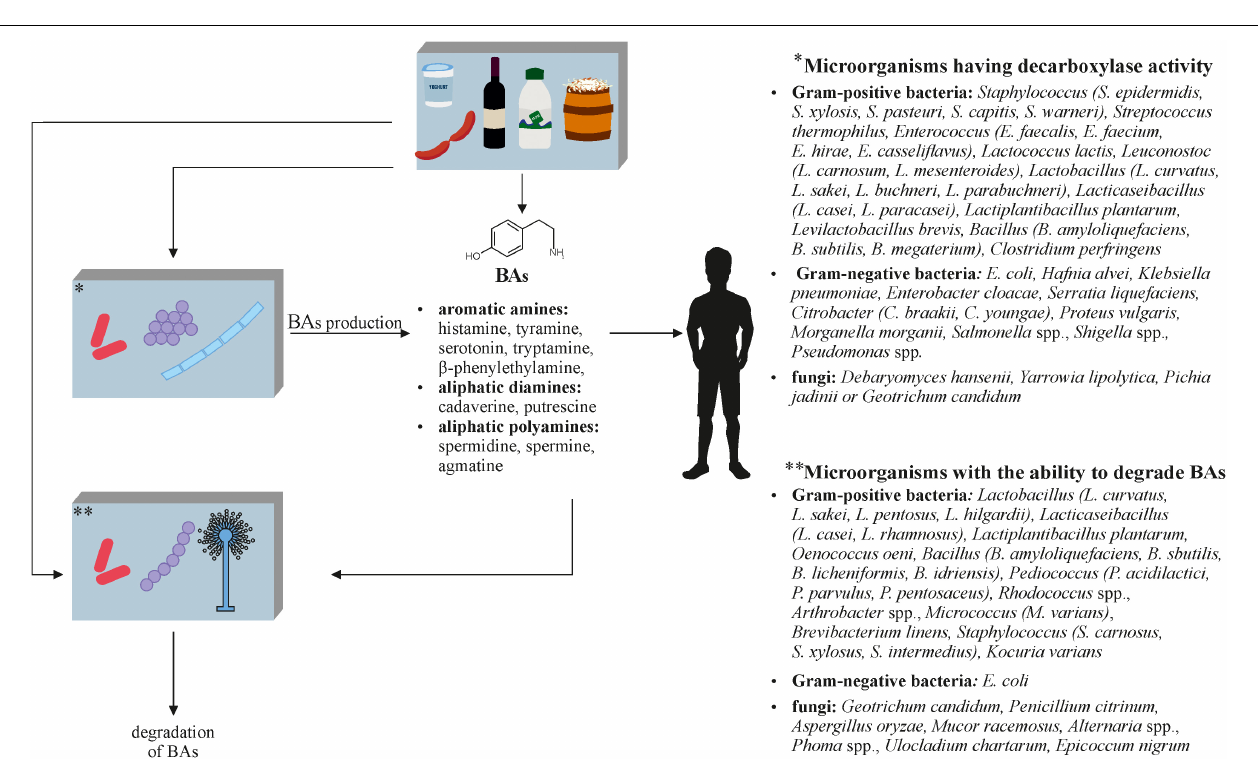
FIGURE 2 | Factors responsible for strain resistance to antibiotics in food and its effect.